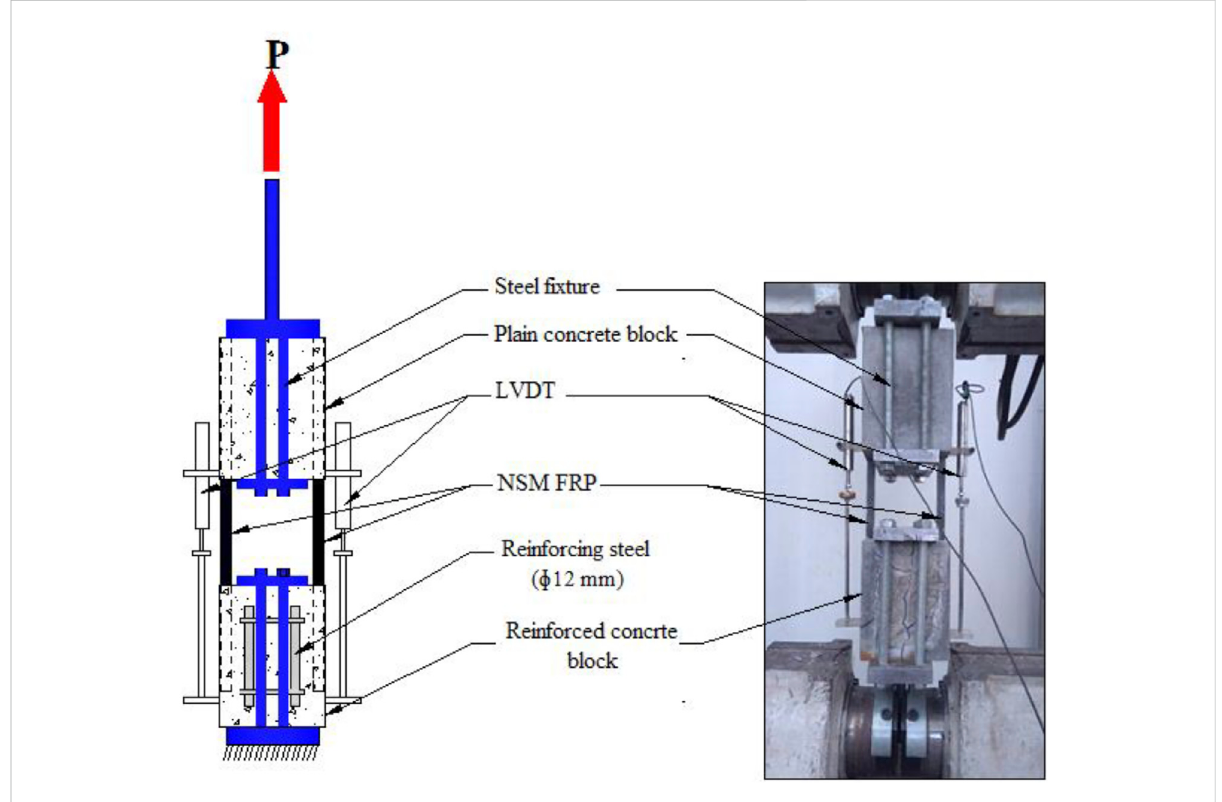
FIGURE 5 Test setup of the double pullout